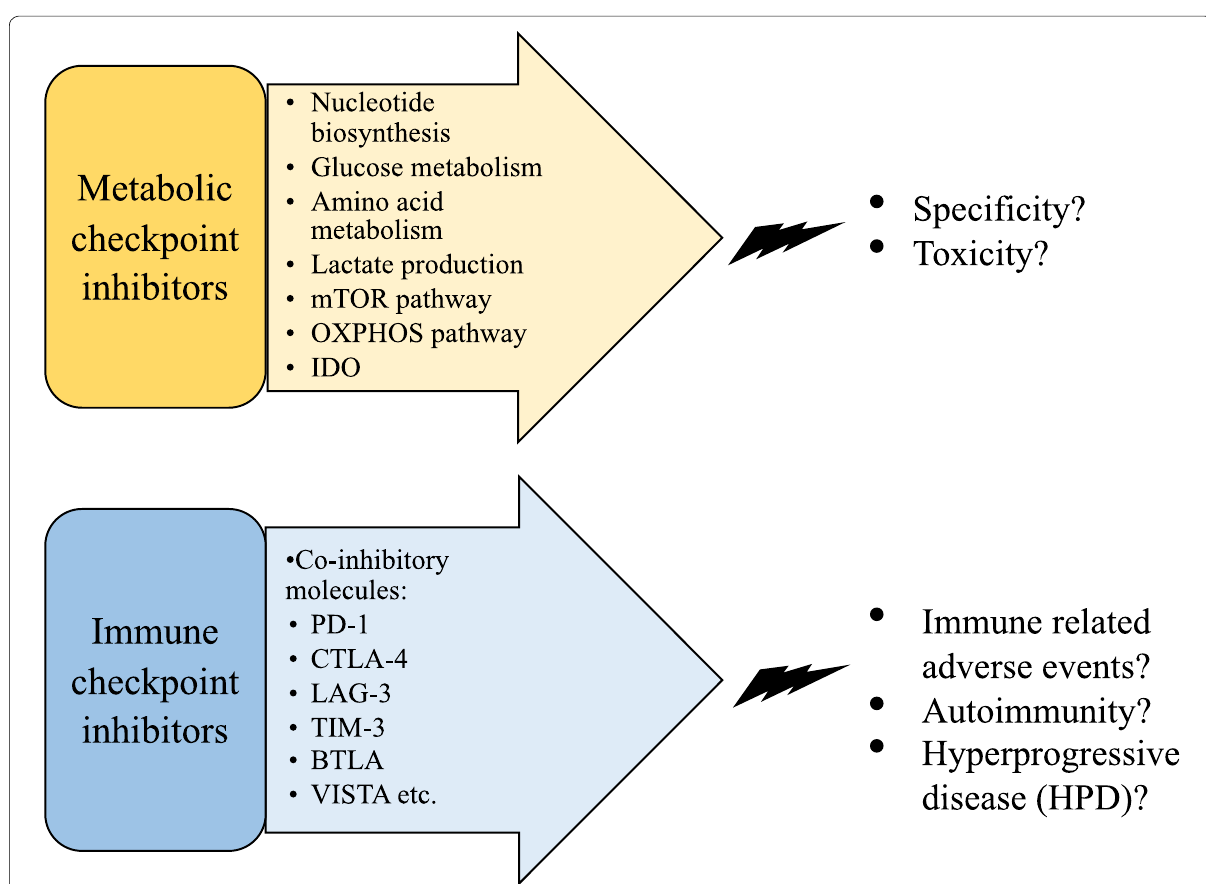
Fig. 5 Clinical applications of immune and metabolic checkpoint inhibitors and their limitations. Various metabolic checkpoint inhibitors (top yellow panel) and immune checkpoint inhibitors (bottom blue panel) are being targeted for cancer therapy. However, while metabolic checkpoint inhibitors lack specificity against tumors resulting in toxicity to host cells, immune checkpoint inhibitors are associated with immune-related adverse events and exacerbation of cancer progression in some